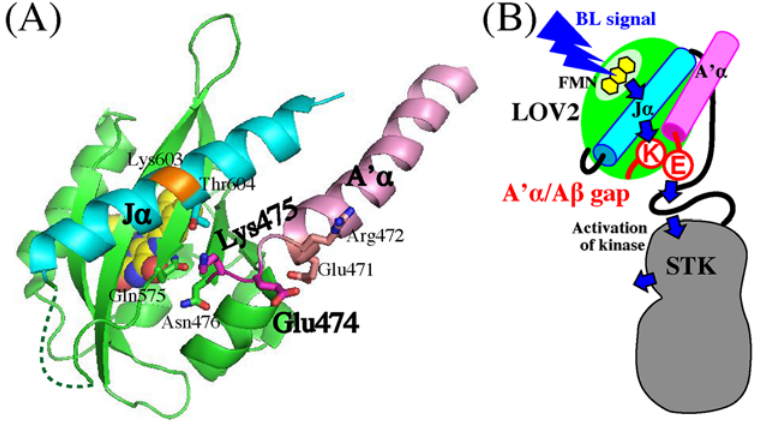
Fig 8. (A) 3D structure of At phot1 LOV2-J α (pdb ID: 4HHD). Key side chains of amino acid residues for intramolecular signaling are indicated with a stick model. FMN is indicated with a space-filling model. A ’ α - helix and J α -helix are colored pink and cyan, respectively. The trypsin-digested site at Lys603 is colored orange. (B) Schematic illustration for the hypothetic intramolecular interactions involved in the BL signaling from FMN to STK of At phot1. Blue arrows indicate the intramolecular signaling. For details, see the “ Discussion ”